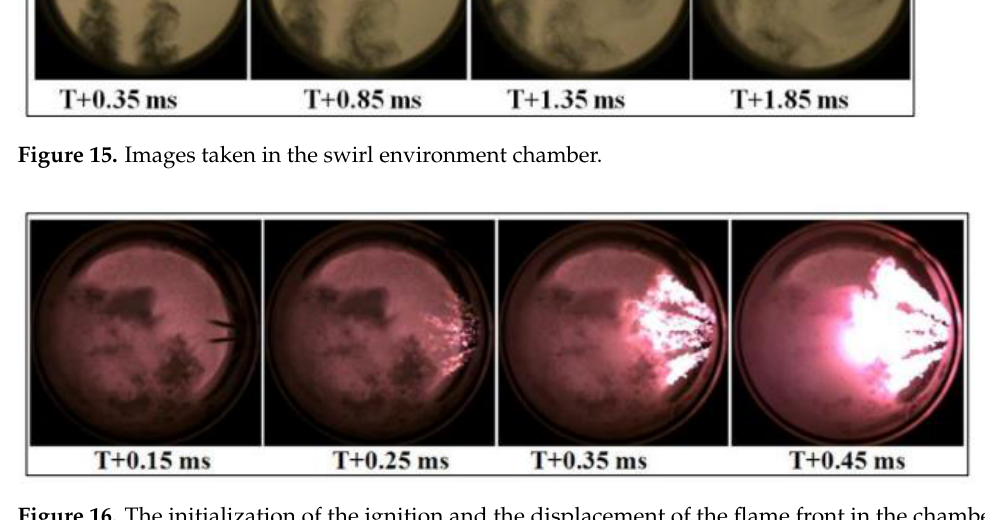
Figure 16. The initialization of the ignition and the displacement of the flame front in the chamber with a stationary environment.